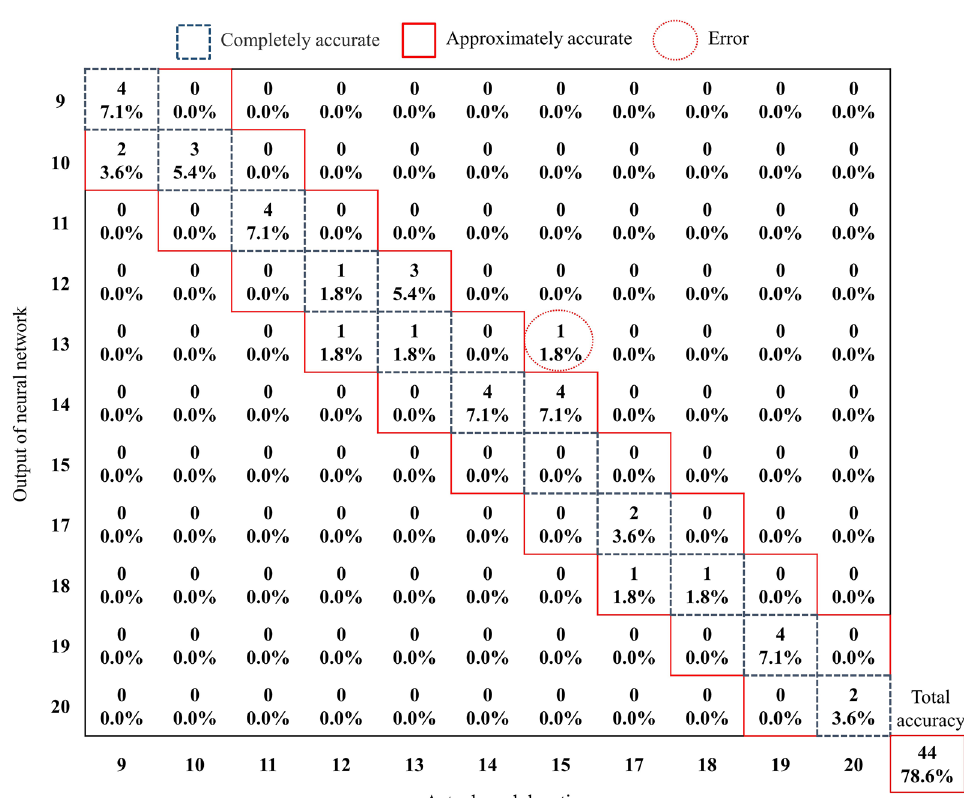
Some other training parameters are summarized in Table 5. The number of hidden neurons is 15. The steps of validation failure are 6, which means that the train- ing process is stopped early when the loss function of the